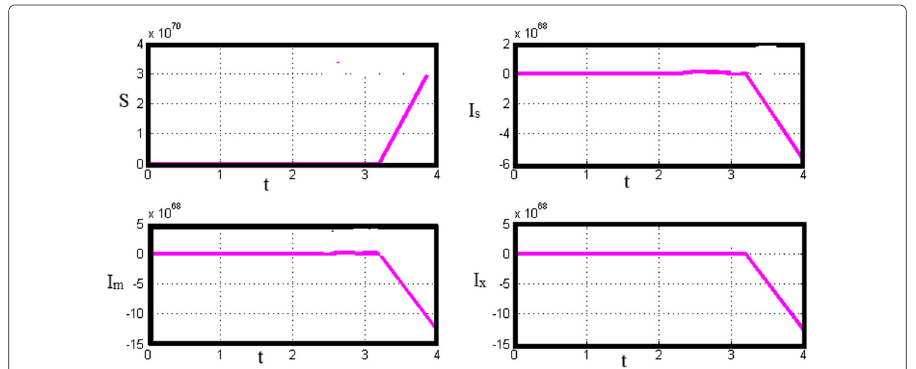
Fig. 10 The approximate solutions with θ = 0.5, ξ = 0.5, h = 1 by using